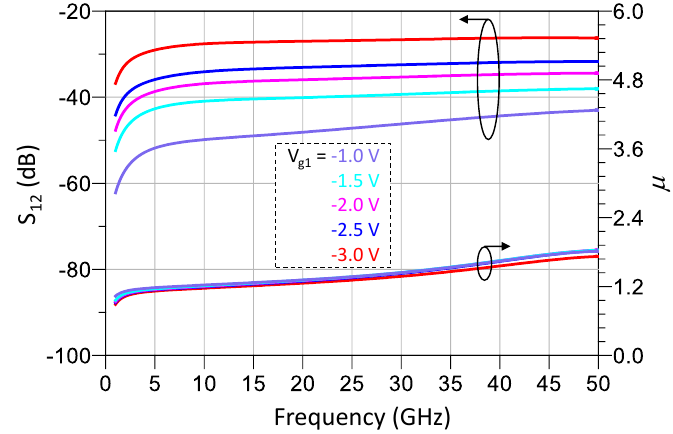
Figure 4. Power gain and noise figure characteristic of the proposed